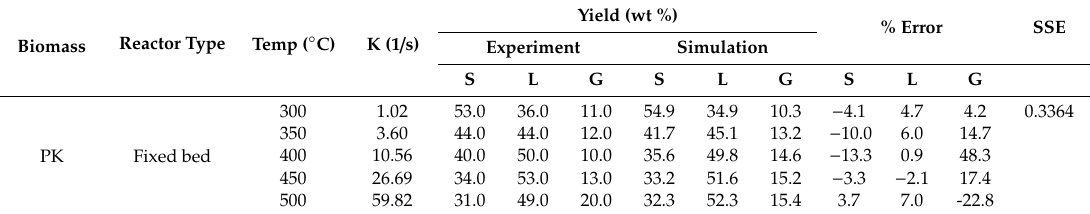
Table 8. Comparison of experimental and simulated pyrolysis yields using experimental data from the work of Abdul Rahman (2016)